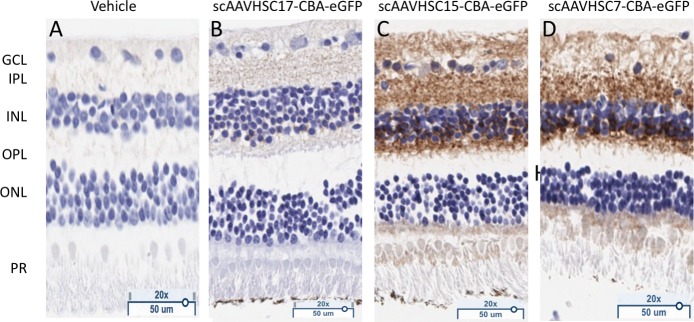
eGFP staining in the retinas of Cynomolgus macaques following IV delivery of scAAVHSC-CBA-eGFP.(A) Animals received an IV dose of vehicle alone. (B) The animal was treated with an IV dose of scAAVHSC17-CBA-eGFP. (C) The animal was treated with an IV dose of scAAVHSC15-CBA-eGFP. (D) The animal received an IV dose of scAAVHSC7-CBA-eGFP. Tissues were harvested two weeks post-dosing and processed for eGFP staining as described under Materials and methods. Brown color represents eGFP detection. Tissue sections were counterstained with thionine. PR = photoreceptor layer, ONL = outer nuclear layer, OPL = outer plexiform layer, INL = inner nuclear layer, IPL = inner plexiform layer, GCL = ganglion cell layer.